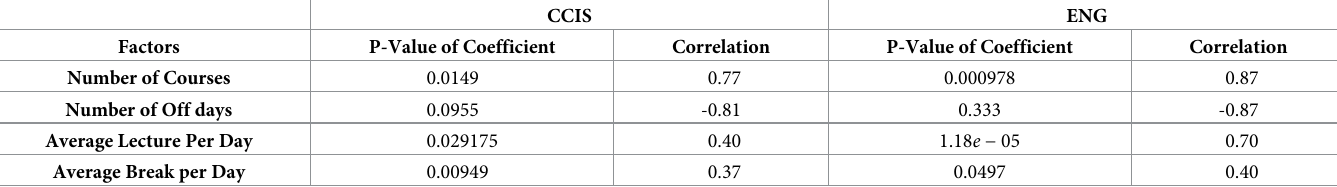
Table 6. Linear Regression results for the absence variable using ENG and CCIS